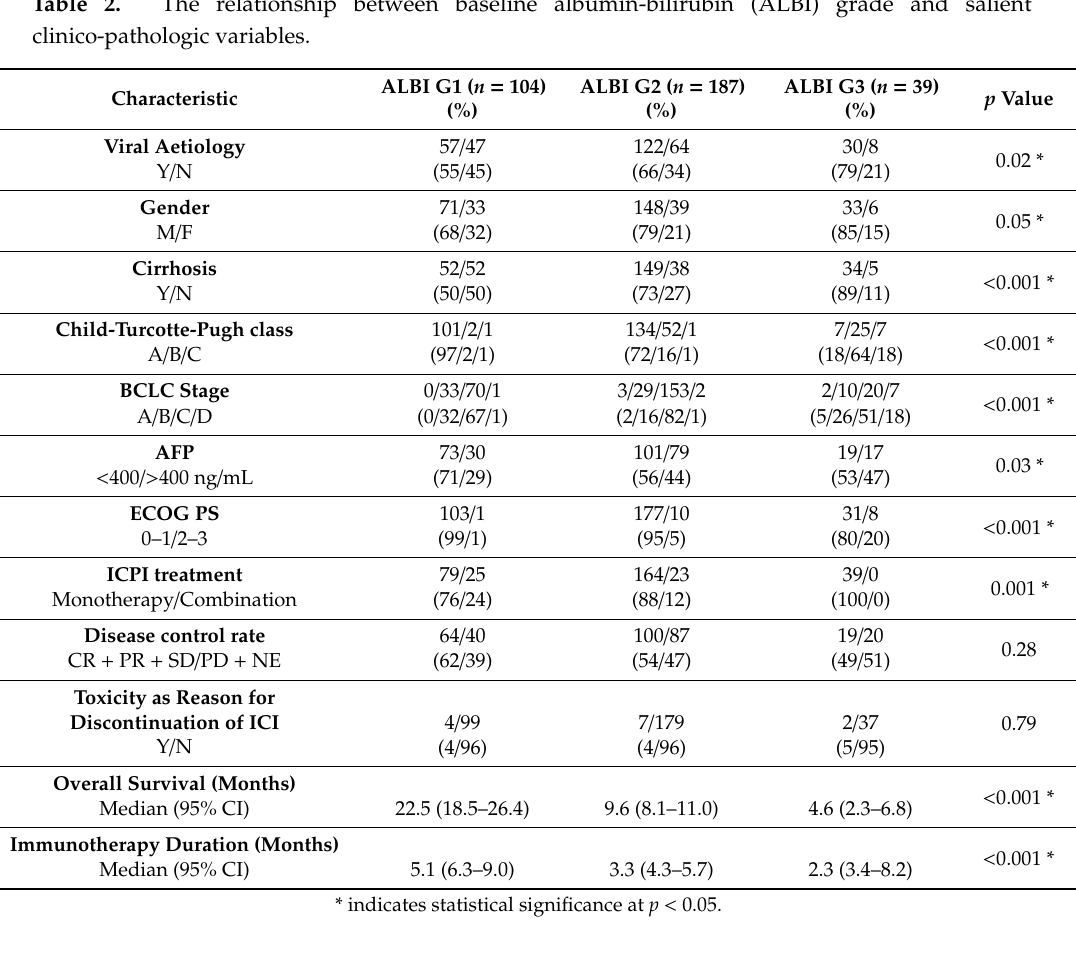
Table 2. The relationship between baseline albumin-bilirubin (ALBI) grade and salient clinico-pathologic variables.